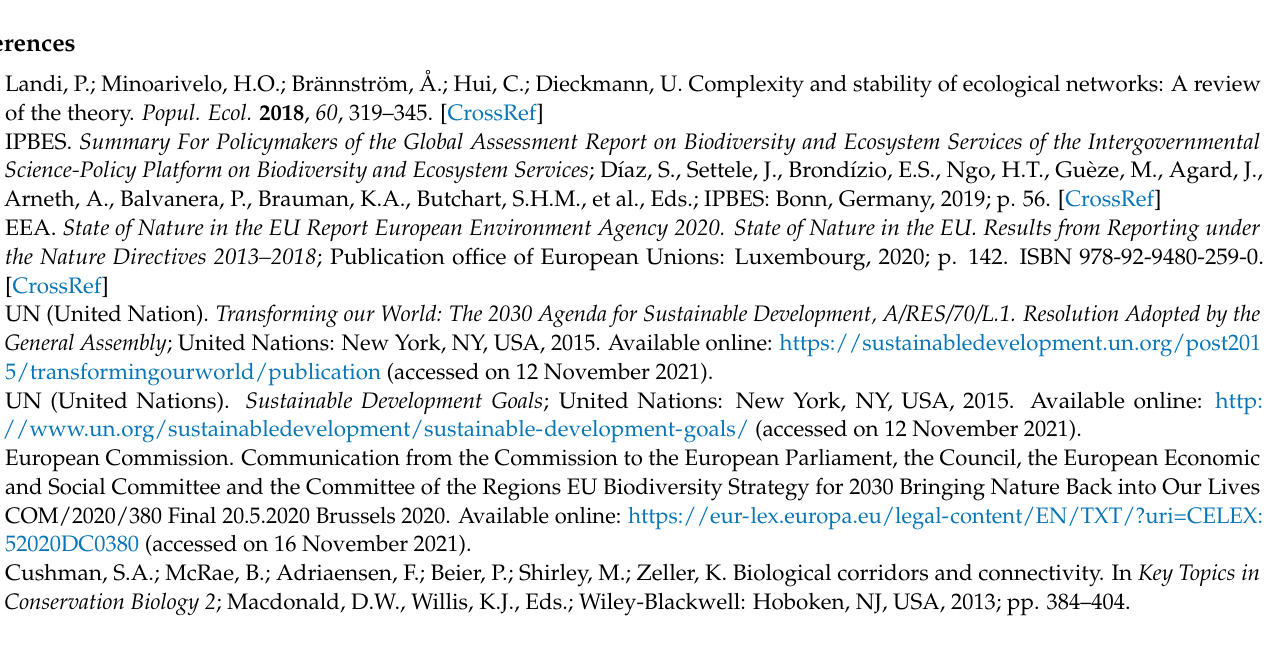
lines) calculated for each habitat of the ecological network. The black solid line represents the RC calculated from the whole dataset, Figure S4: Classic rarefaction curves (RCs) calculated for each node of ecological network. The black dashed line represents the RC calculated from the whole dataset, Figure S5: MultSE profile based on Bray–Curtis dissimilarity for each node within the ecological network, Figure S6: MultSE profile based on Bray–Curtis dissimilarity for the whole dataset within the ecological network, Table S1: Estimated sample size for each habitat based on the slope change in the linear relation between MultSE and sample size. The value could not be estimated in habitat types with 3 or less replicates (NA = Not assessed, see main